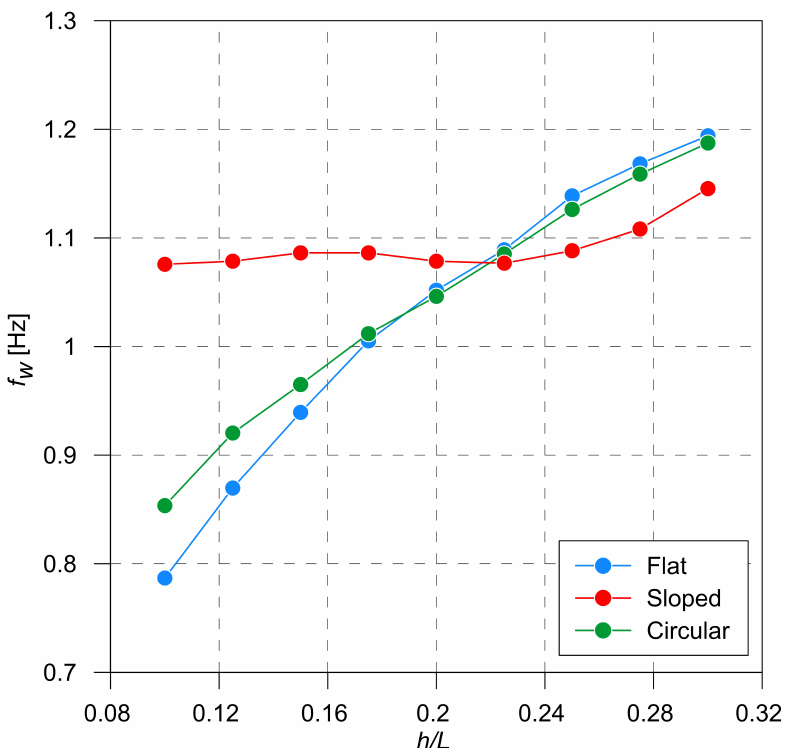
Figure 10. Natural frequency values vs. water depth ratio for different bottom geometries.